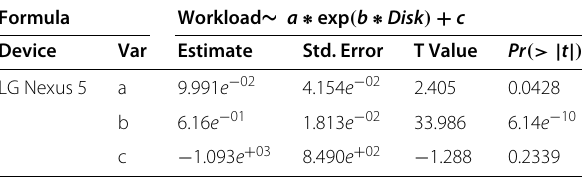
Table 4 The non-linear regression analysis